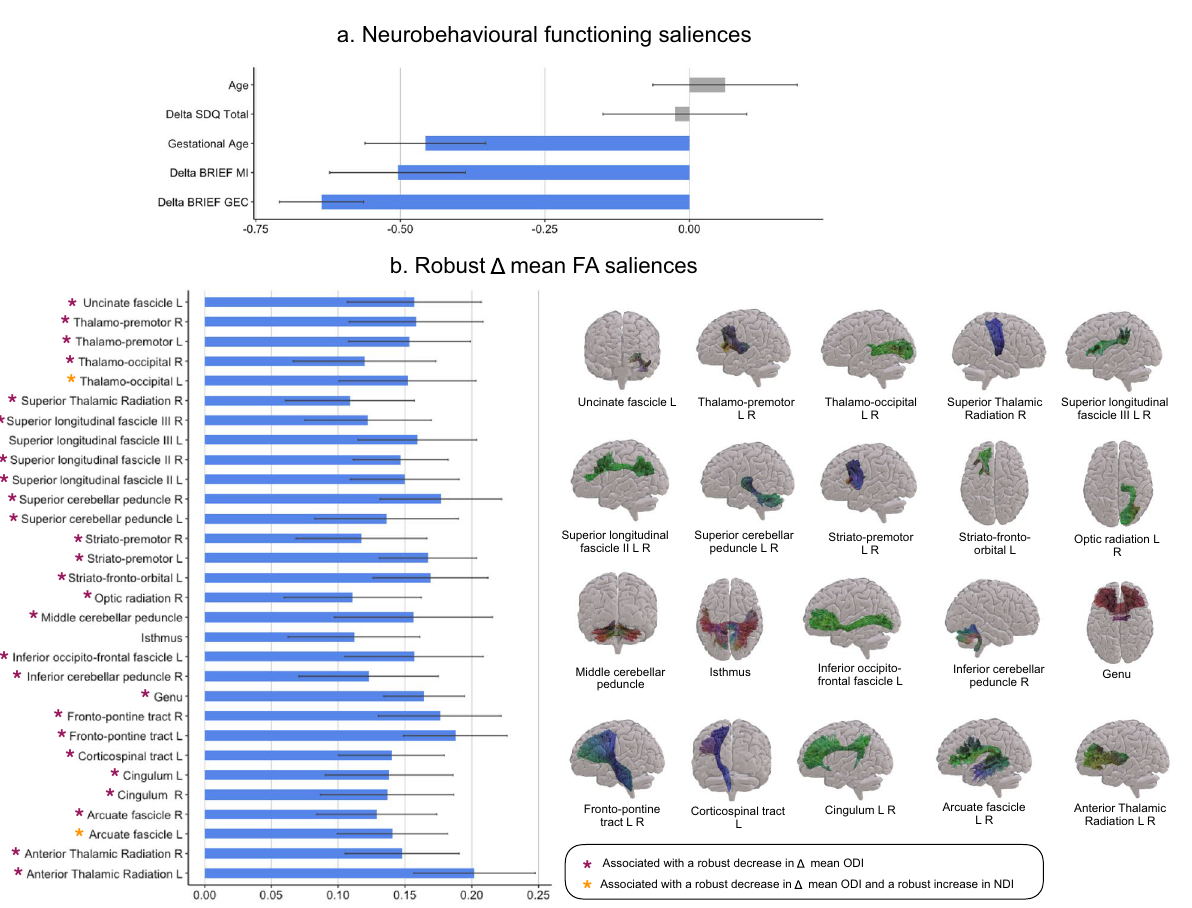
Figure 6. Associations between neurobehavioural functioning and Δ mean FA and Δ mean ODI based on the PLSC analysis. ( A ) Neurobehavioural functioning saliences: the diverging graph show mean saliences averaged across bootstrap samples and their bootstrap-estimated standard deviations (x-axis) for each neurobehavioural functioning measure (y-axis); robust saliences are represented in blue. Of note, saliences bellow 0 indicate a decreased in scores after MBI and saliences above 0 indicate an increased in scores after MBI. ( B ) Robust Δ mean FA saliences: the diverging graph show robust mean saliences averaged across bootstrap samples and their bootstrap-estimated standard deviations (x-axis) for each Δ mean FA along a given tract (y-axis). The tracts extracted from TractSeg and showing robust Δ mean FA saliences are shown on the right side and the colour code for principal direction of diffusion is used: red (left–right), green (anterior–posterior), blue (inferior–superior). Based on the results from the second PLSC analyses: pink star indicates a robust negative contribution of Δ mean ODI along the given tract associated with a similar pattern of neurobehavioural functioning saliences; and orange star indicates both a robust negative contribution of Δ mean ODI and a robust positive contribution of Δ mean NDI along the given tract associated with a similar pattern of neurobehavioural functioning saliences. Of note, saliences below 0 indicate a decreased in scores after MBI and saliences above 0 indicate an increased in scores after MBI; L left, R